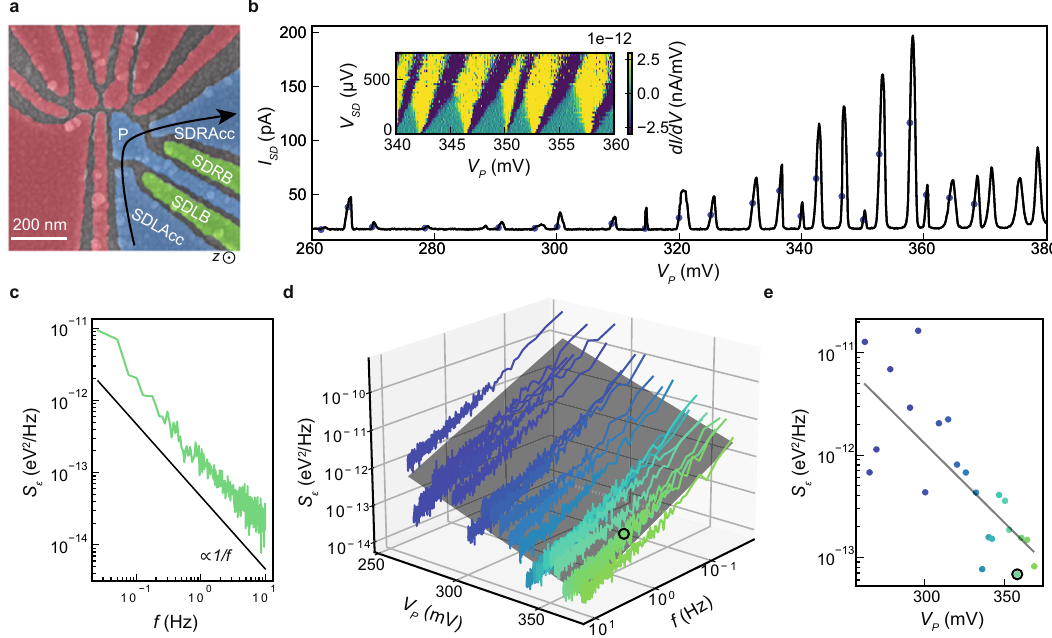
Fig. 2 | Quantum dots and charge noise measurements. a False colored SEM- imageofadoublequantumdotsystemwithanearbychargesensor.Chargenoiseis measured in the multi-electron quantum dot de fi ned by accumulation gates SDLAccandSDRAcc(blue),plungerP(blue),withthecurrentgoingalongtheblack arrow. In these experiments, the gates de fi ning the double quantum dot (red) are used as screening gates. There is an additional global top gate (not shown) to facilitate charge accumulation when needed. b Source-drain current I SD through a charge sensor device fabricated on heterostructure C against the plunger gate voltage V P .Coloreddotsmarkthepositionofthe fl ankoftheCoulombpeakwhere charge noise measurements are performed. The inset shows Coulomb diamonds fromthesamedevice,plottedasthedifferentialofthecurrent dI / dV asafunctionof